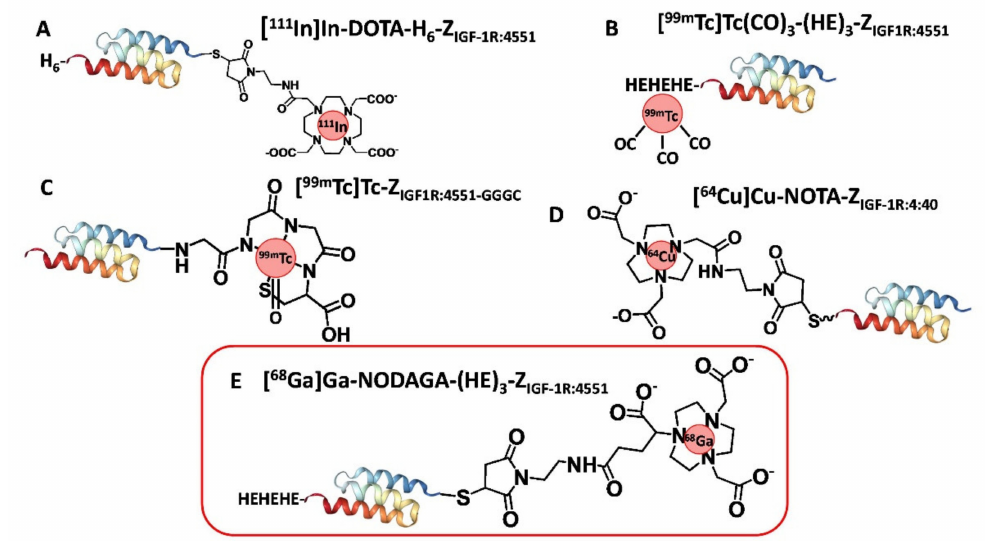
Figure 1. Structures of affibody molecules, which were evaluated for imaging of IGF-1R ex- pression. ( A ) 111 In]In-DOTA-H 6 -Z IGF-1R:4551 , ( B ) [ 99m Tc]Tc(CO) 3 -(HE) 3 -Z IGF-1R:4551 , ( C ) [ 99m Tc]Tc- Z IGF-1R:4551 -GGGC, ( D ) 64 Cu-NOTA-Z IGF-1R:4:40 , ( E ) [ 68 Ga]Ga-NODAGA-(HE) 3 -Z IGF-1R:4551 . The affibody molecule [ 68 Ga]Ga-NODAGA-(HE) 3 -Z IGF-1R:4551 (evaluated in this study) is marked with a red